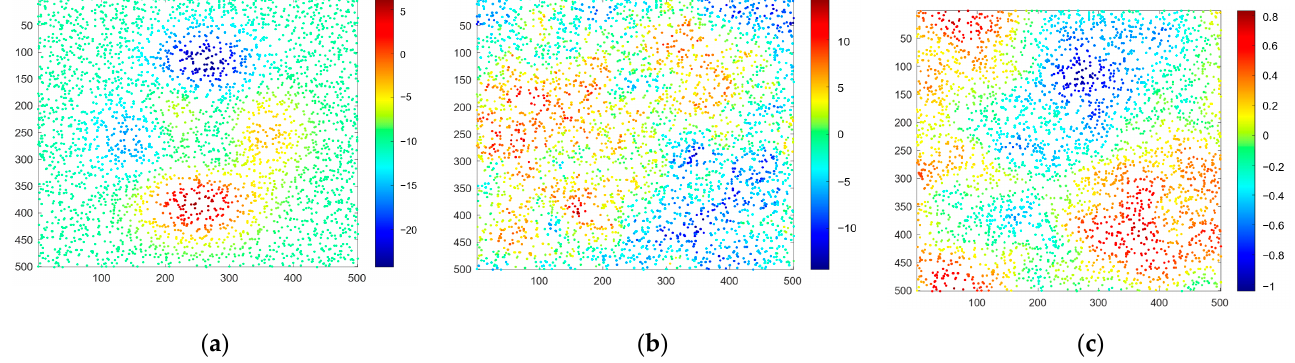
Figure 4. The simulated phase consists of ( a ) the deformation signals (mm/year); ( b ) residual elevation errors (m); and ( c ) atmospheric phases (rad).